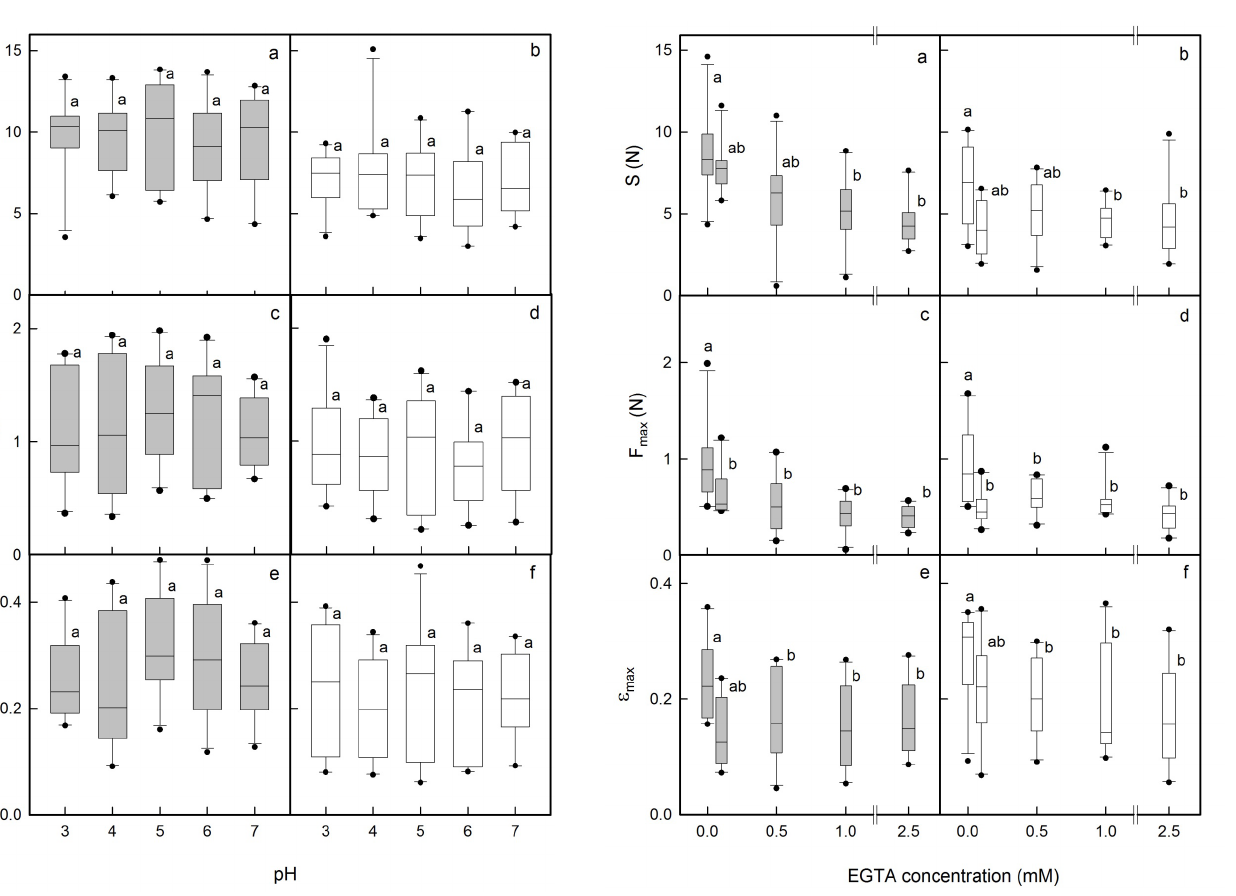
Fig. 6: Effect of pH on stiffness (S) (a, b), maximum force (F max ) (c, d) and maximum strain ( ε max ) (e, f) of internodes (a, c, e) and nodes (b, d, f) of Chara corallina . Pooled data for positions 2 and 3. The effect of pH was not significant (P < 0.05).